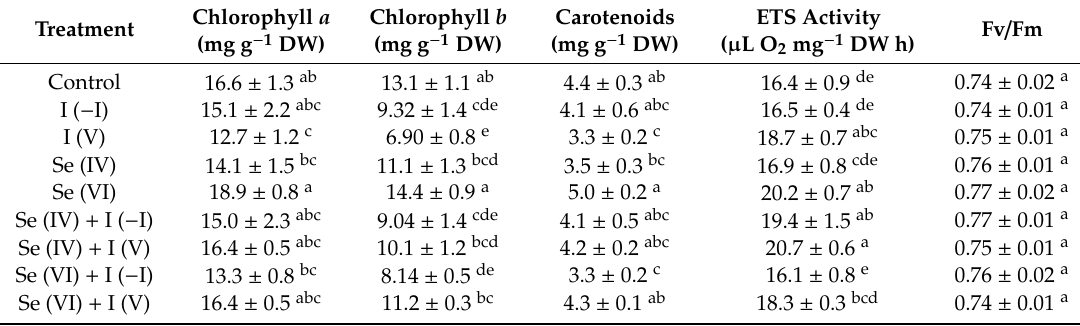
Table 2. Effects of different treatments on the selected biochemical and physiological parameters. Treatment